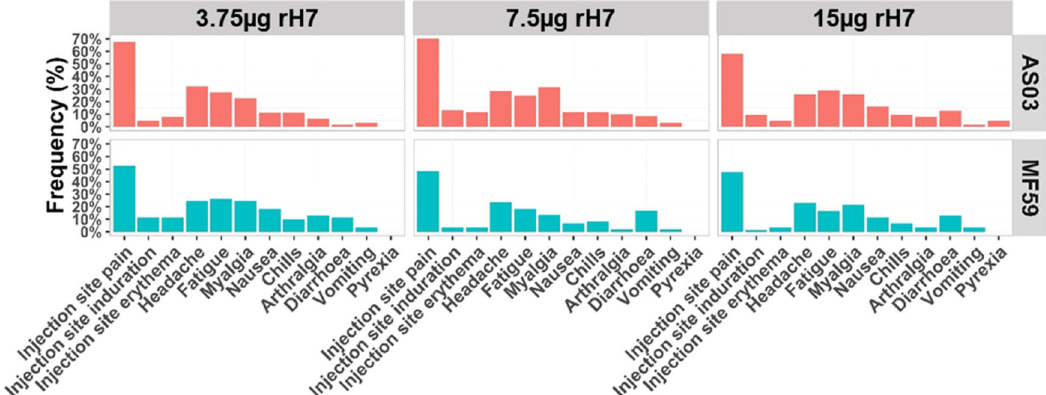
Fig. 2 Frequency of adverse events by vaccine received. Solicited local reactions at the injection site included pain, induration, and erythema. Solicited systemic reactions included headache, fatigue, myalgia, nausea, chills, arthralgia, diarrhoea, vomiting, and